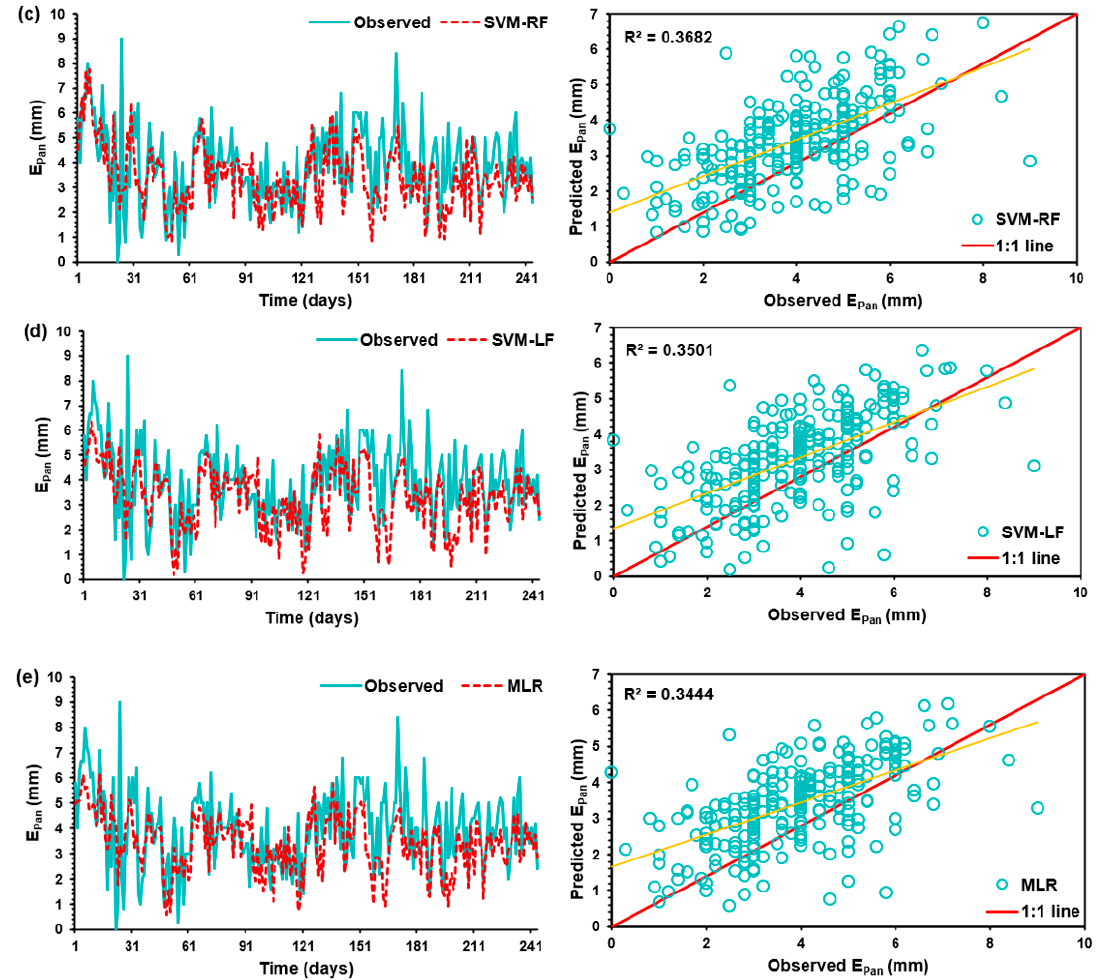
Figure 6. Line and scatter plot between observed and predicted data at Scenario 1 for ( a ) ANN, ( b ) WANN ( c ) SVM-RF, ( d ) SVM-LF, and ( e ) MLR for the study area.